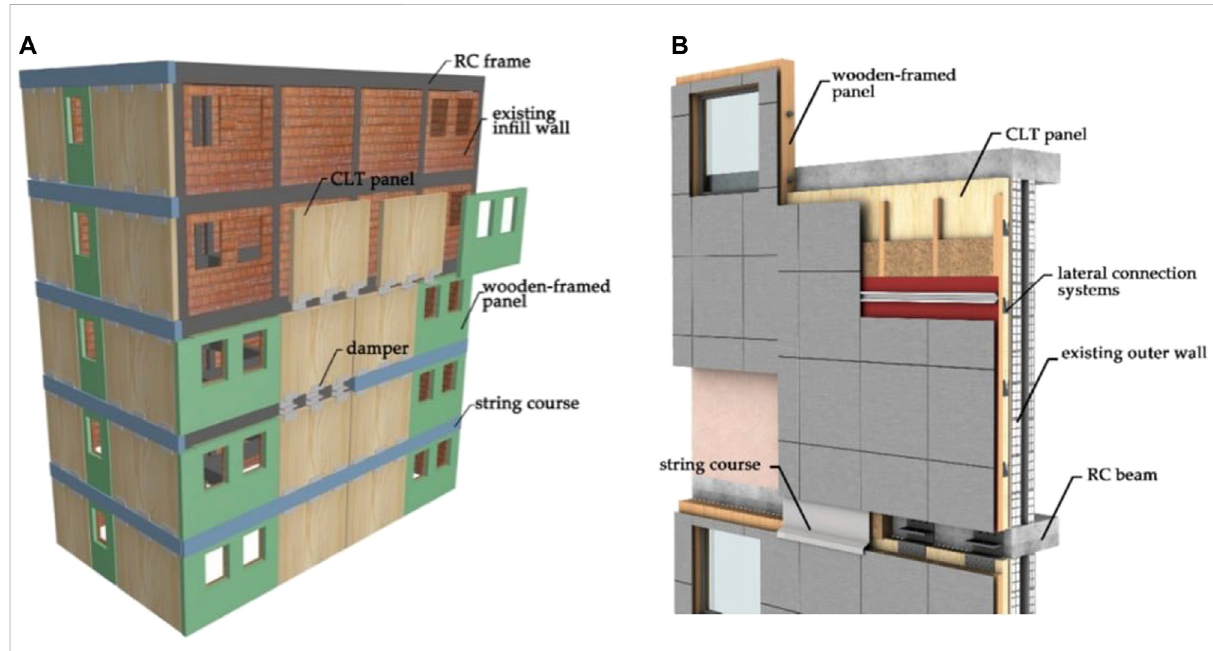
FIGURE 6 CLT retro fi tting solution: (A) conceptual scheme; (B) detailing of the prefabricated timber panels combined with ventilated façade system (Margani et al., 2020).